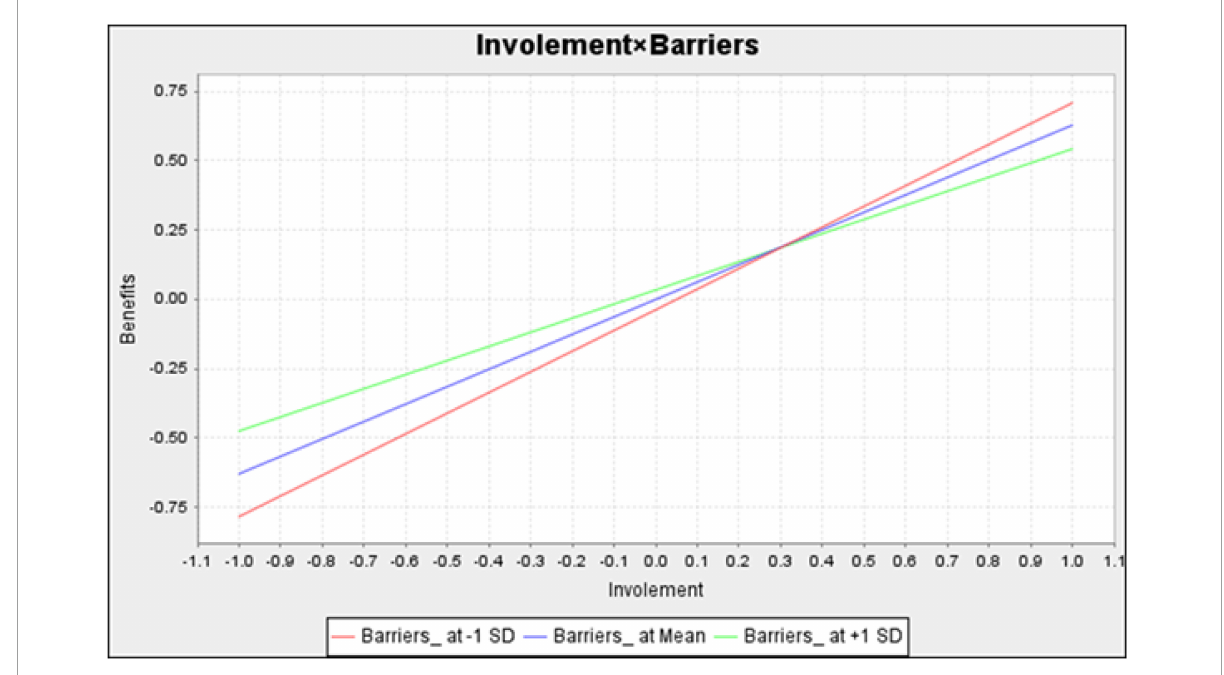
FIGURE4 Simple slope analysis of interaction term “water leisure involvement × water leisure